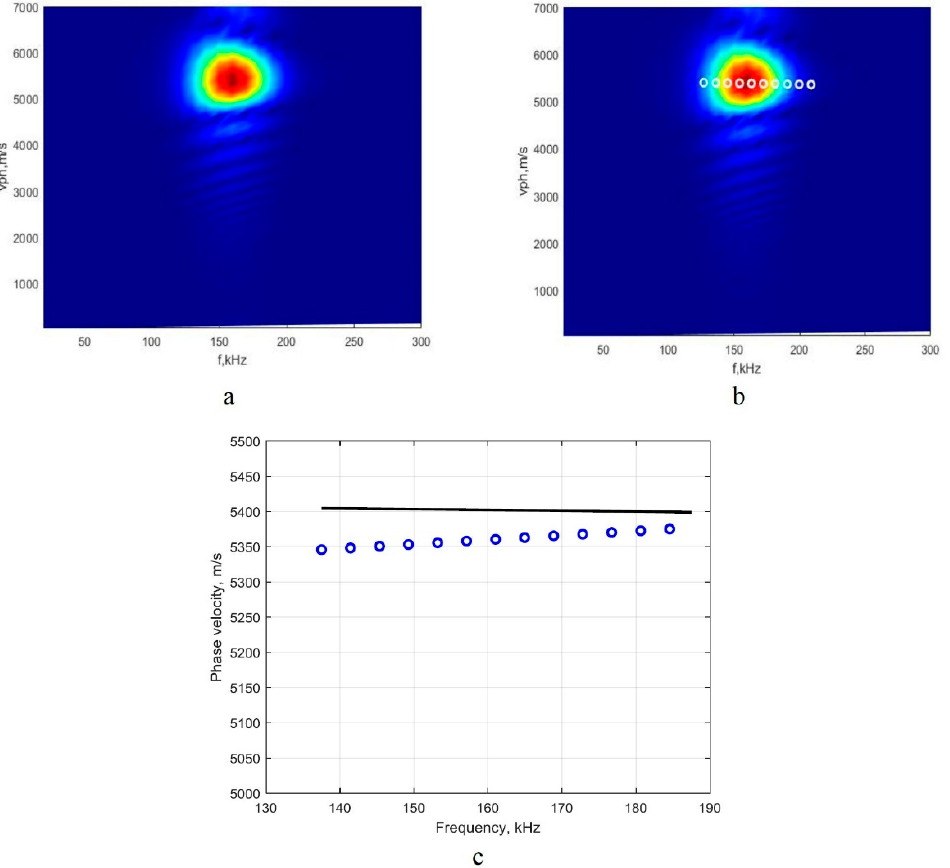
Figure 5. Image of the S 0 -mode phase-velocity dispersion curve segment obtained by 2D-FFT method ( a ); reconstructed quantitative values of the dispersion curves segment, using the analyzed method ( b ); and the dispersion curve segment obtained by using the analytical method (package ’DISPERSE’, the solid line) and reconstructed by using the analyzed algorithm (circles) ( c ).